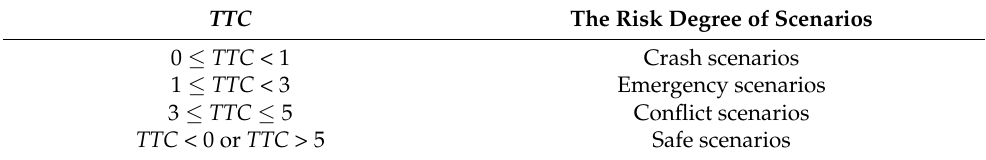
Boundaries of two-dimensional ISSD are shown in Figure 7. The yellow, green, pale blue and navy blue regions represent crash, emergency, conflict, and safe scenarios, respectively.